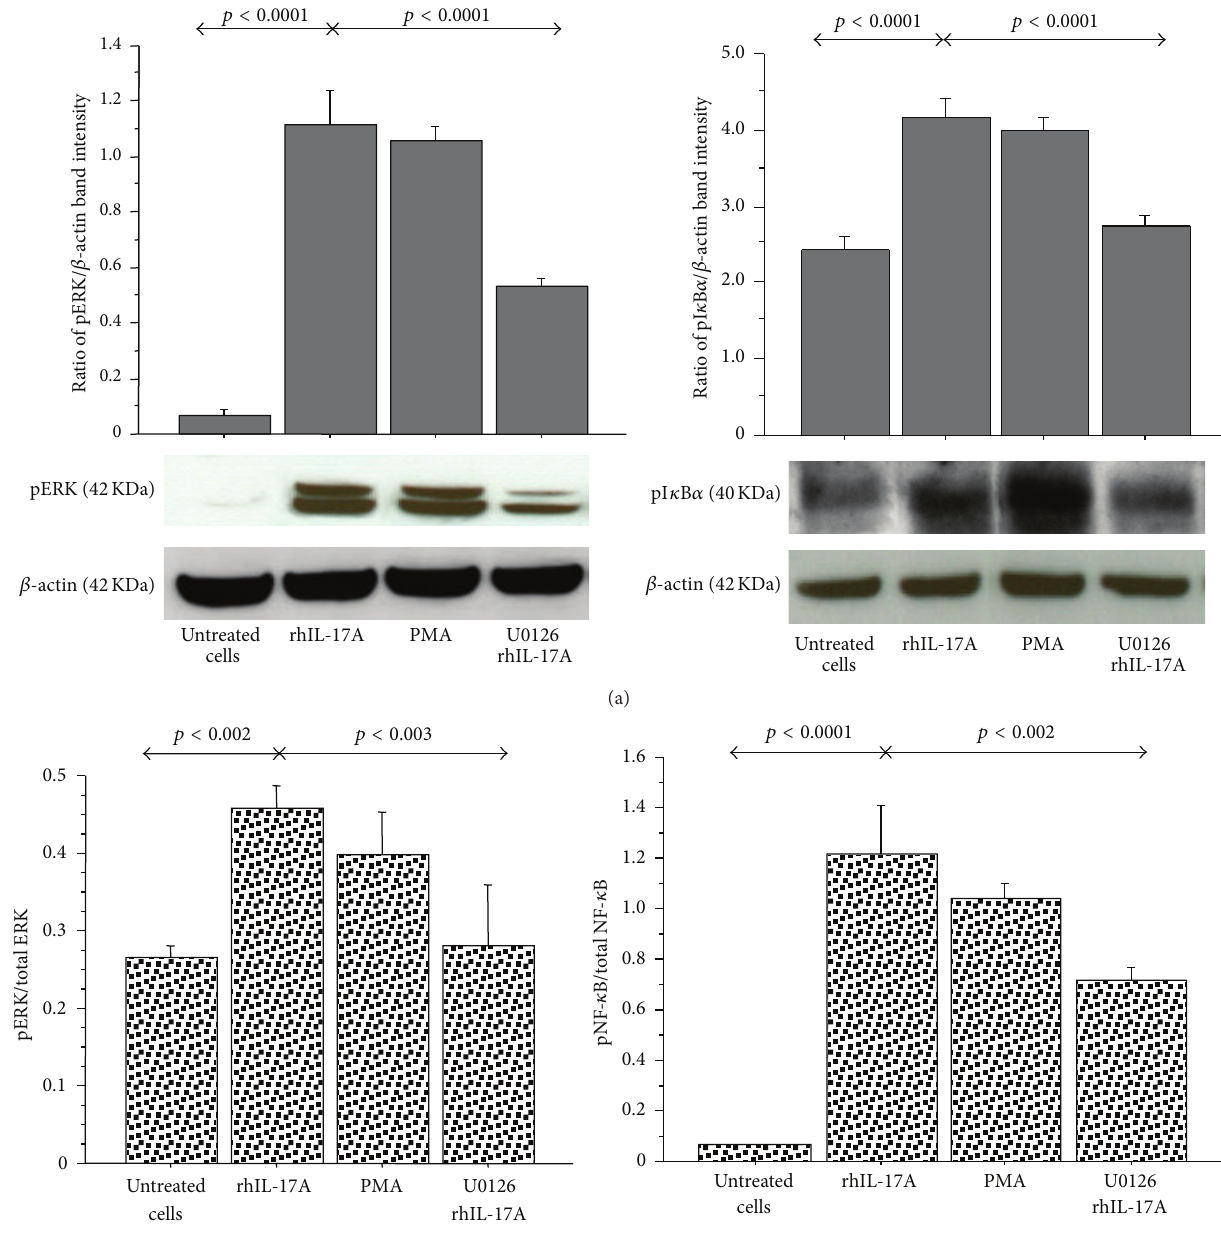
Figure 1: Effect of U0126 inhibitor on ERK and I 𝜅 B 𝛼 phosphorylation in RPMI 2650 cells stimulated with rhIL-17A. The cells were stimulated with rhIL-17A (20ng/mL) or PMA (50ng/mL) for 30 min in absence or presence of U0126 (25 𝜇 M). (a) pERK and pI 𝜅 B 𝛼 protein expression were evaluated in the cell lysates by western blot. The results were expressed as ratio of band intensity and 𝛽 -actin of 3 separate experiments. Representative gel images of pERK, pI 𝜅 B 𝛼 , and 𝛽 -actin are shown. (b) The activation of ERK1/2 and NF- 𝜅 B for each experimental condition was tested for the pERK1/2/total ERK1/2 ratio and for the pNF- 𝜅 B/total NF- 𝜅 B, respectively, by ELISA and normalized for protein content. ANOVA with Fisher’s test correction was used for the analysis of the data. 𝑝 < 0.05 was statistically